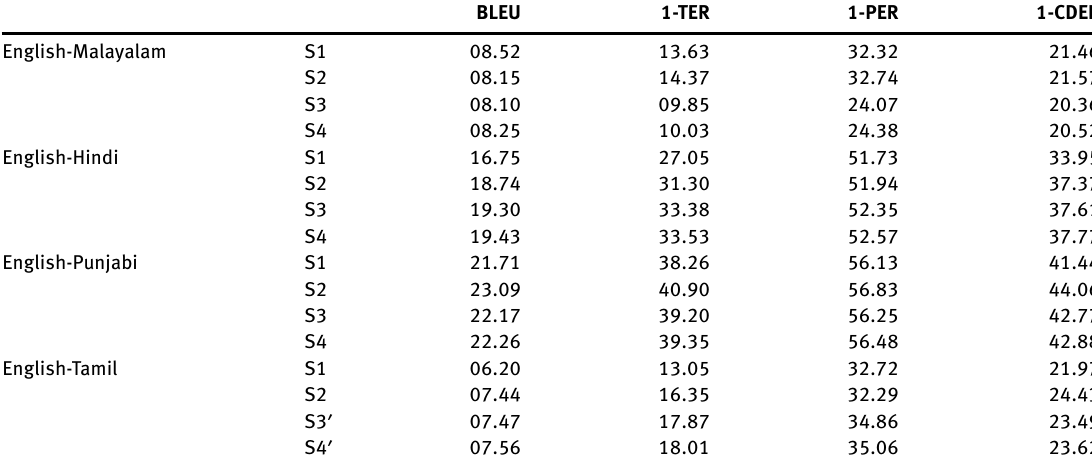
Table 5: Translation Quality Scores for Different